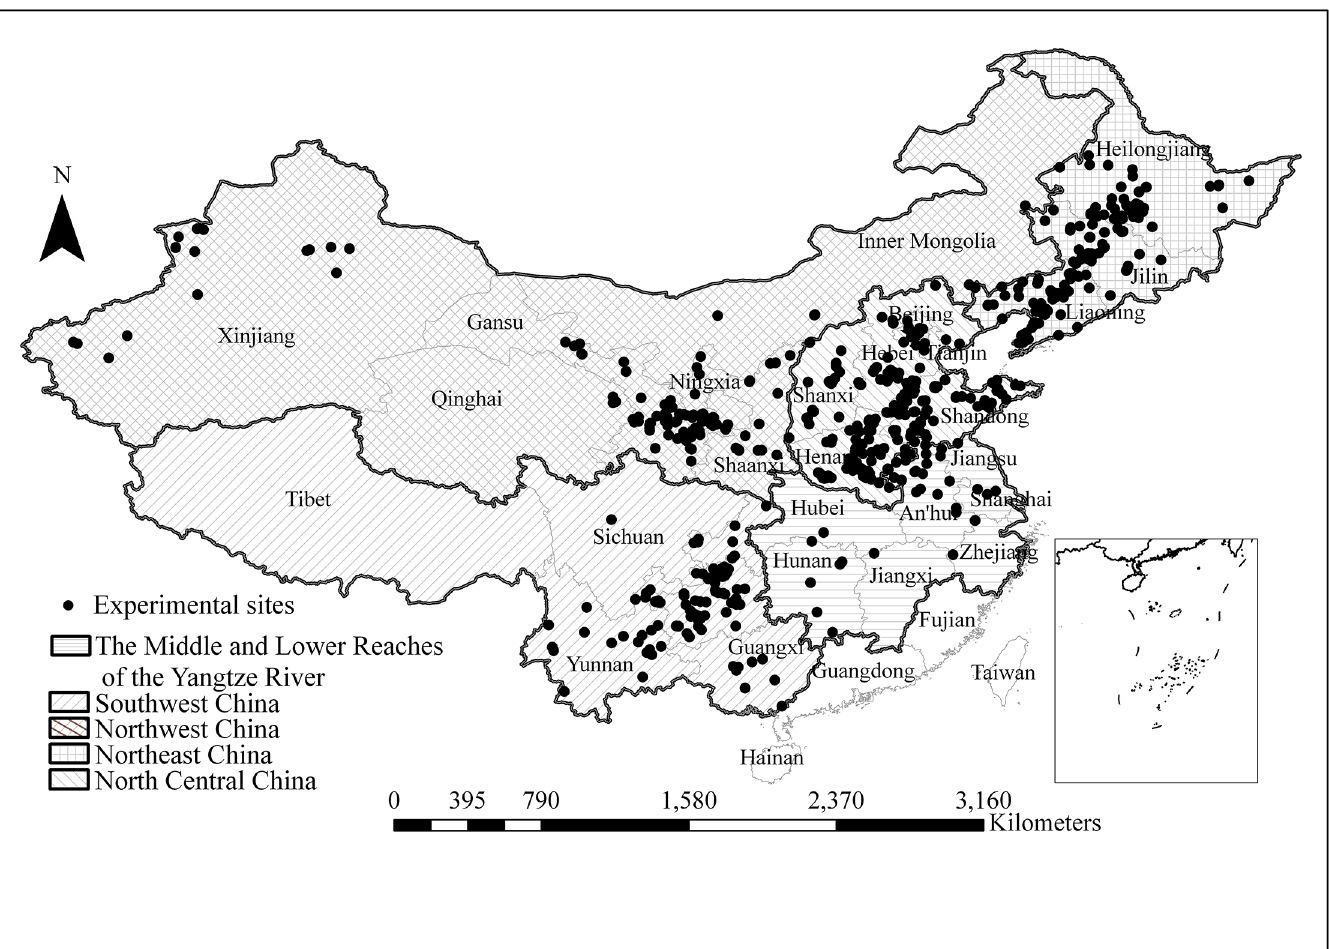
Fig 1. Geographical distribution of the studied locations in the Northeast (NE), North-Central (NC), Northwest (NW), Southwest (SW) and the Middle and Lower Reaches of the Yangtze River (MLYR) of